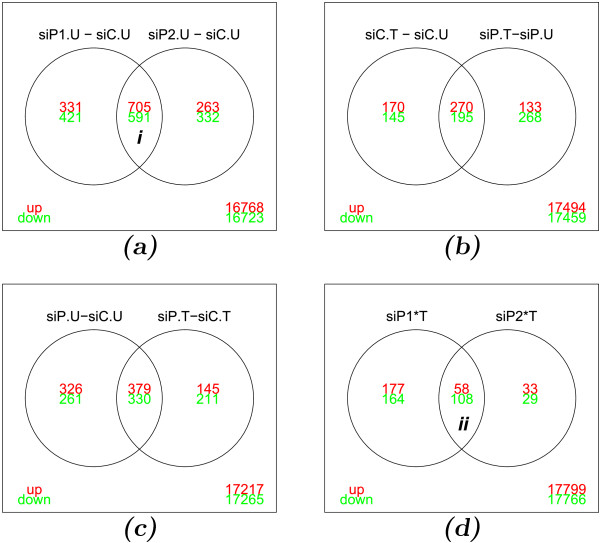
Venn diagrams of significantly affected genes. (a) Significantly affected genes following PML knockdown by two independent siRNAs (siP1, siP2) compared to control siRNA (siC) in HUVECs without TNFα treatment. The intersection of both circles (i) is considered significantly affected genes by PML knockdown (designated as “siP.U-siC.U”). (b) Comparison between TNFα responsive genes (“siC.T-siC.U”) and TNFα responsive genes when PML was knocked down (“siP.T-siP.U”). (c) Comparison between PML-knockdown responsive genes in the absence of TNFα treatment (i, “siP.U-siC.U” from a) and in the presence of TNFα treatment (“siP.T-siC.T”). (d) Identification of genes interactively regulated by PML knockdown (two siRNAs, siP1 and siP2) and TNFα treatment. The intersection of both circles (ii) is considered significantly affected interaction genes. Untreated samples, “U”; TNFα treated samples, “T”; comparison between two samples, “-”; interaction effects, “∗”. Numbers in the circles, the number of significantly altered genes (>1.5fold,q < 0.05) by the indicated comparison. Numbers in the outer box, the number of unchanged genes; up-regulation, “up” shown in red; down-regulation, “down” shown in green.